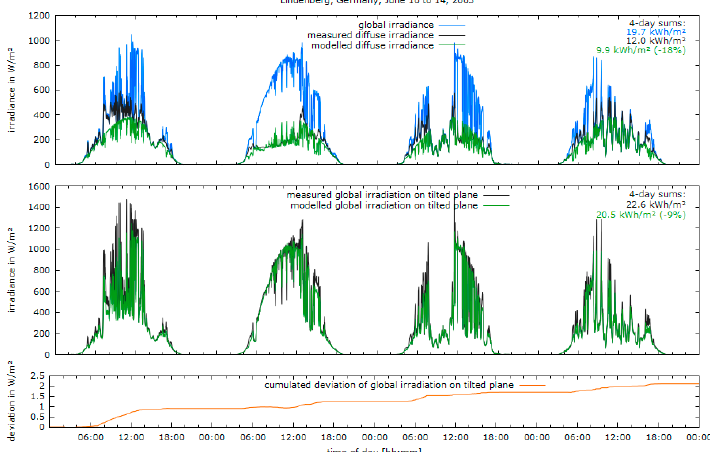
Figure 1. Top : Measured (grey) and modelled (green) time series of diffuse irradiance on a horizontal surface for four days in Lindenberg, Germany. Global irradiance (blue) for reference. The calculation of diffuse irradiance in this example was done with the reduced model of Reindl et al. [3]. The model underestimates the four-day sum of the diffuse irradiation by 18%. Middle : The global irradiance on a tilted photovoltaic (PV) module (facing south, tilted by 30°) for the same four days. The model used for calculating the irradiance on a tilted surface is from Hay and Davies [4]. Due to the underestimation of the diffuse irradiance (see top), the four-day sum of the global irradiation on the PV module based on modelled values falls below the global irradiation based on measured values by − 9%. Bottom : The resulting cumulated deviation of the modelled global irradiation on the tilted plane from